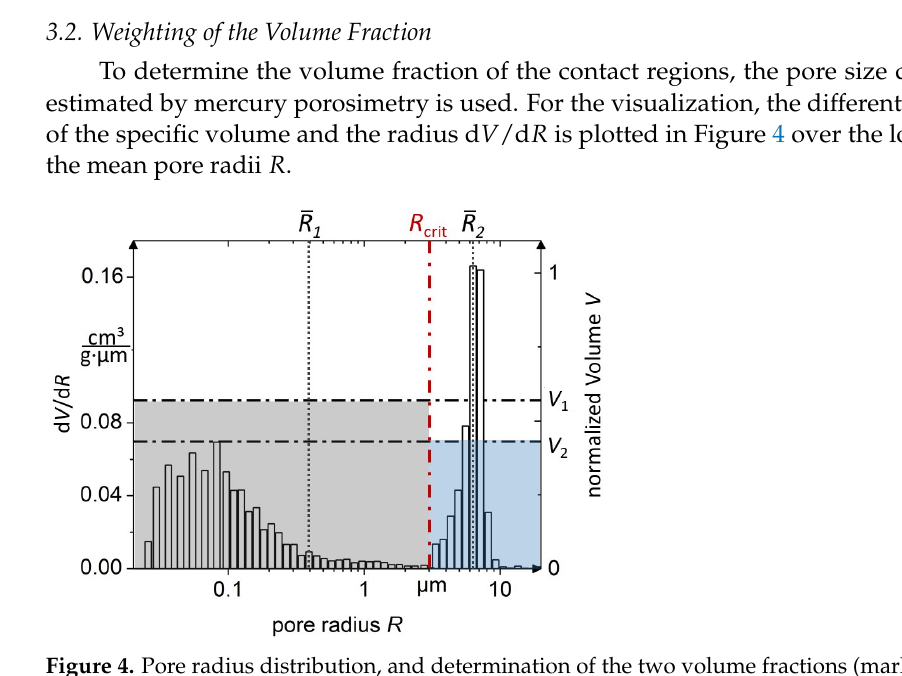
Figure 4. Pore radius distribution, and determination of the two volume fractions (marked blue and gray area), separated by R crit